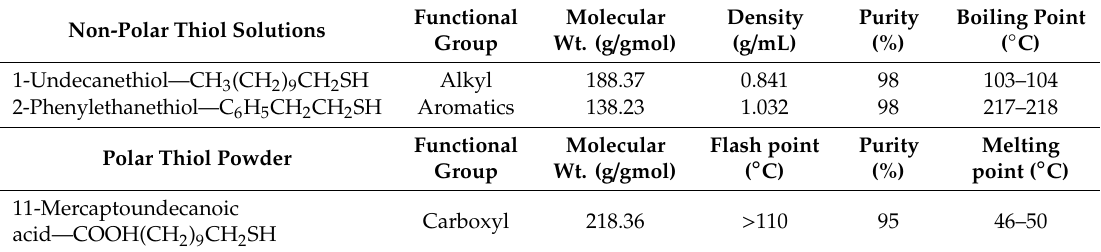
Table 3. Thiol solutions used to functionalize AFM probes, and key properties.